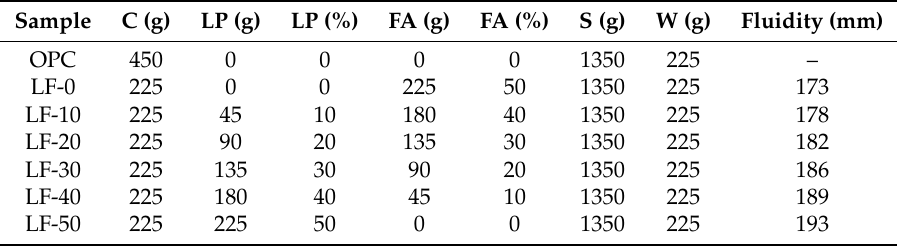
Table 2. Mix proportion of the mortar